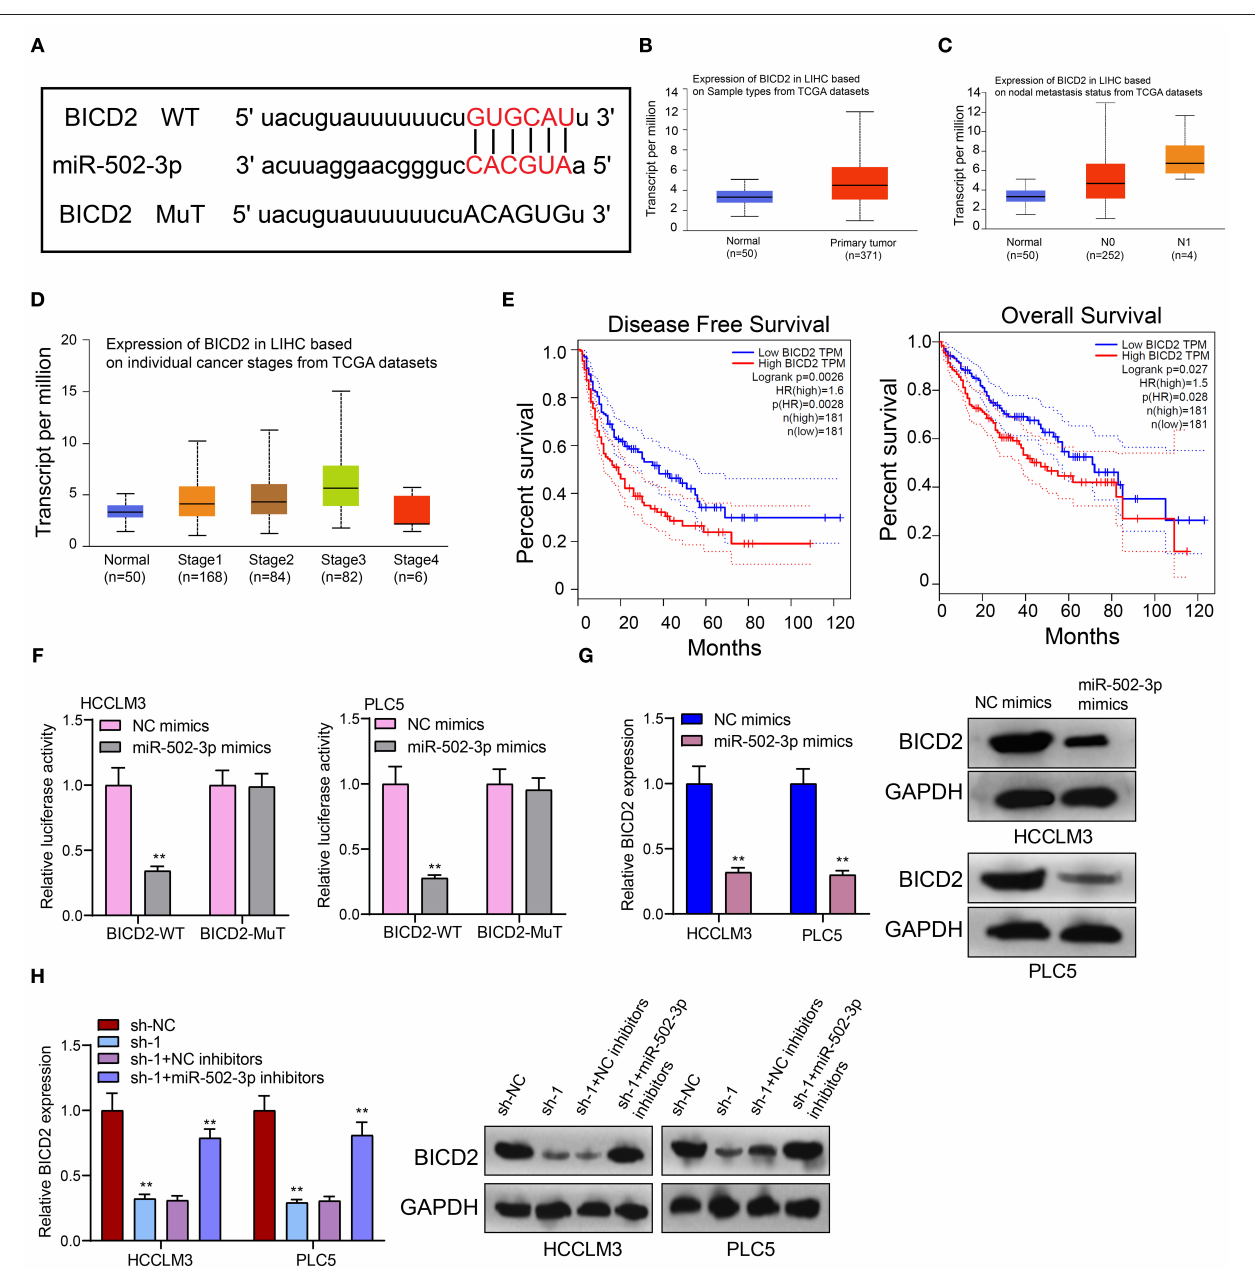
FIGURE 6 | BICD2 is a prognostic factor for HCC and is a potential target of miR-502-3p. (A) The schematic diagram of the binding sites between BICD2 and miR-502-3p. (B) Box plots for the expression of BICD2 in HCC and normal samples from TCGA database. (C) The differences in BICD2 expression in HCC patients with or without nodal metastasis. (D) The expression of BICD2 among different stages. (E) Kaplan-Meier curves for DFS and OS between high and low BICD2 expression among HCC patients. (F) The luciferase reporter assay for the direct relationship between BICD2 and miR-502-3p. (G) Western blot for BICD2 expression in HCC cells with miR-502-3p mimics or NC. (H) Western blot for BICD2 expression in HCC cells with PRKAG2-AS1 shRNA and/or miR-502-3p inhibitors. ** p < 0.01.